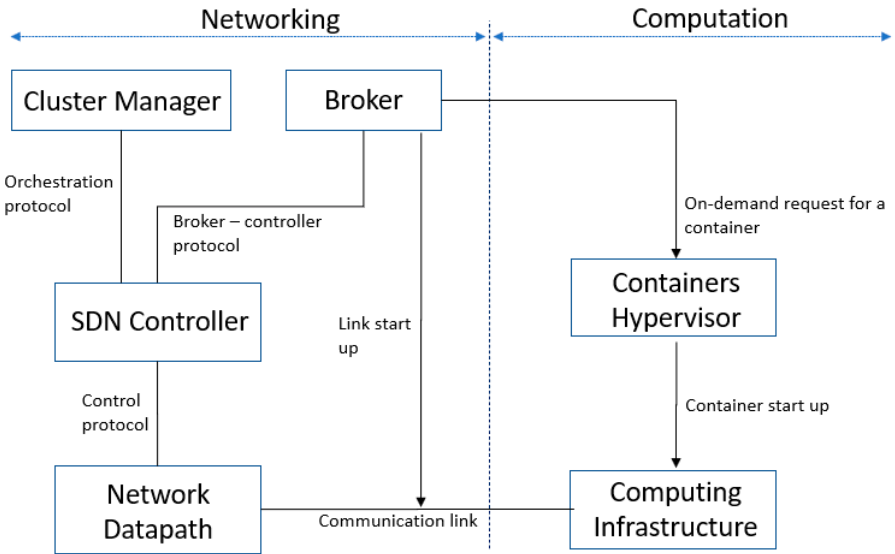
Figure 1. The proposed architecture with two operation domains, aggregating, respectively, net- working and computation edge resources.